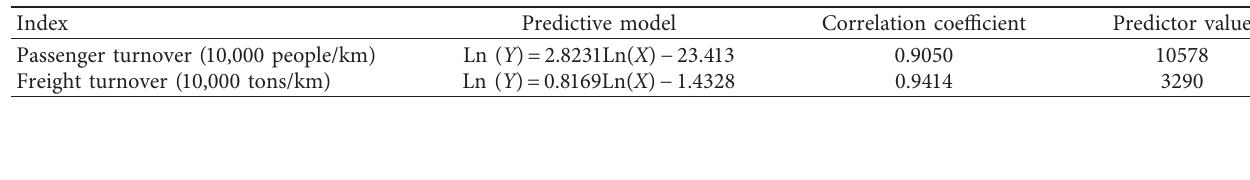
Table 7: Evaluation of nondimensional index value